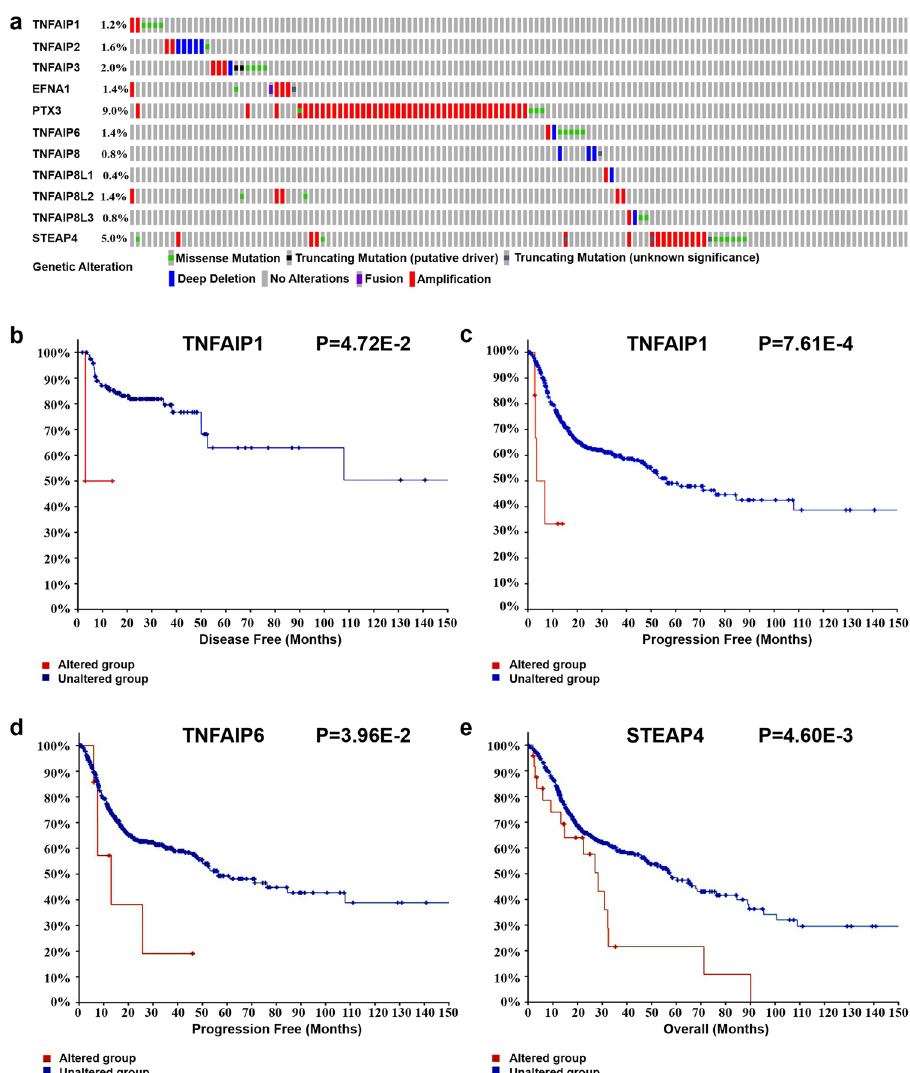
Figure 5. Genetic alterations of TNFAIPs in HNC patients and their effect on prognosis. ( a ) Summary of alterations in TNFAIPs. ( b ) The DFS and ( c ) PFS curves of HNC patients with/without TNFAIP1 alteration. ( d ) The PFS curve of HNC patients with/without TNFAIP6 alteration. ( e ) The OS curve of HNC patients with/ without STEAP4 alteration